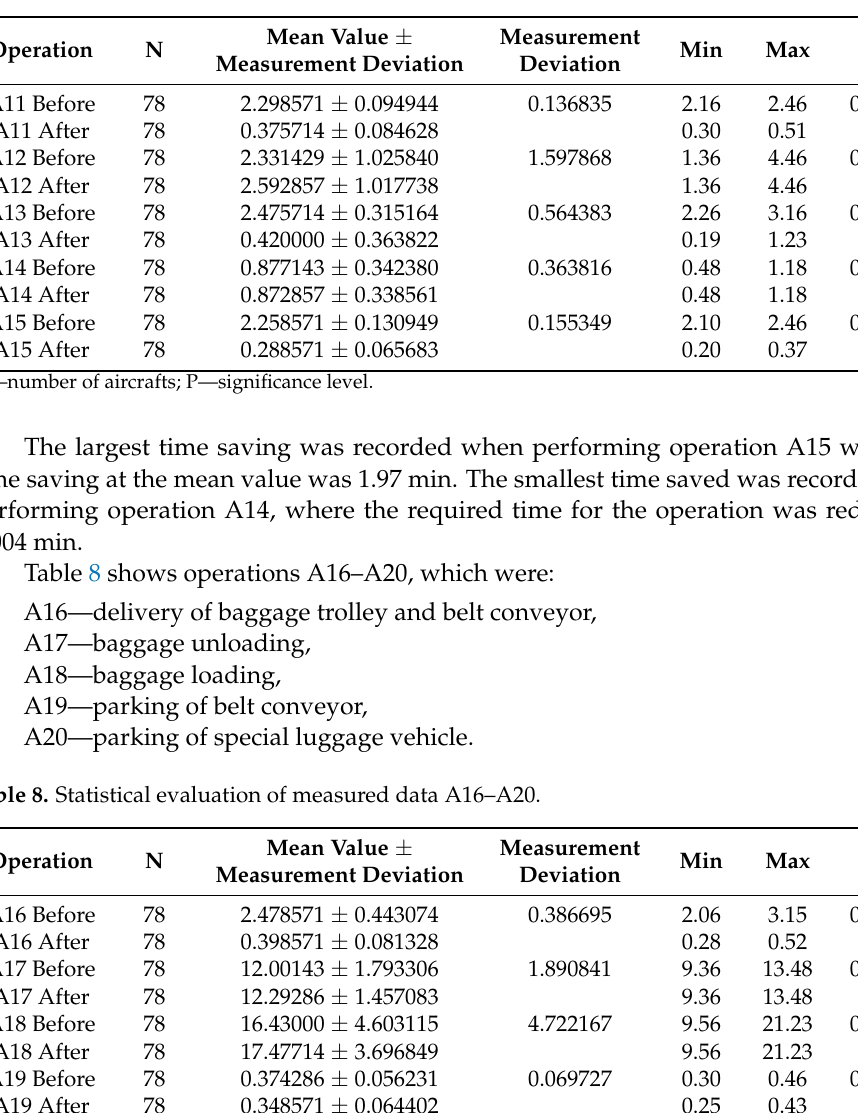
Table 7. Statistical evaluation of measured data A11–A15.